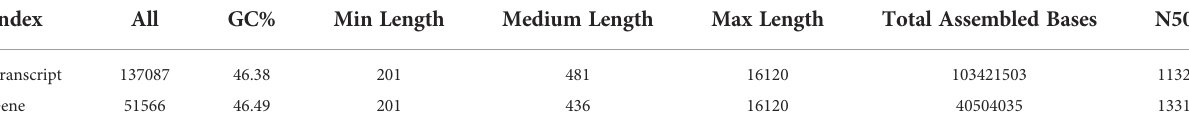
TABLE 3 Summary of trinity assembly